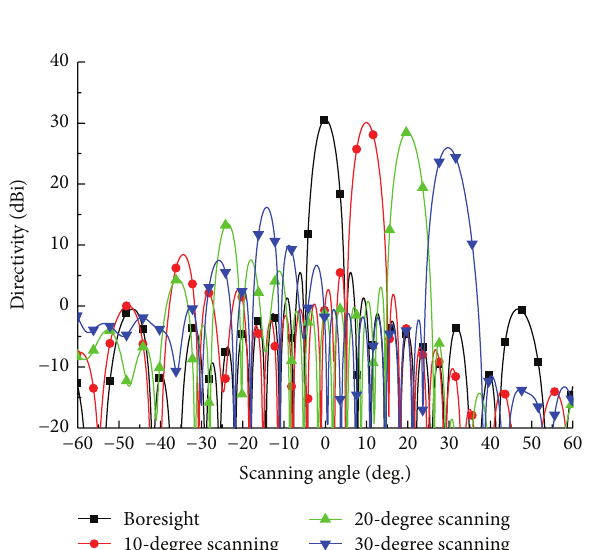
Figure 13: Scanning beam of proposed sparse